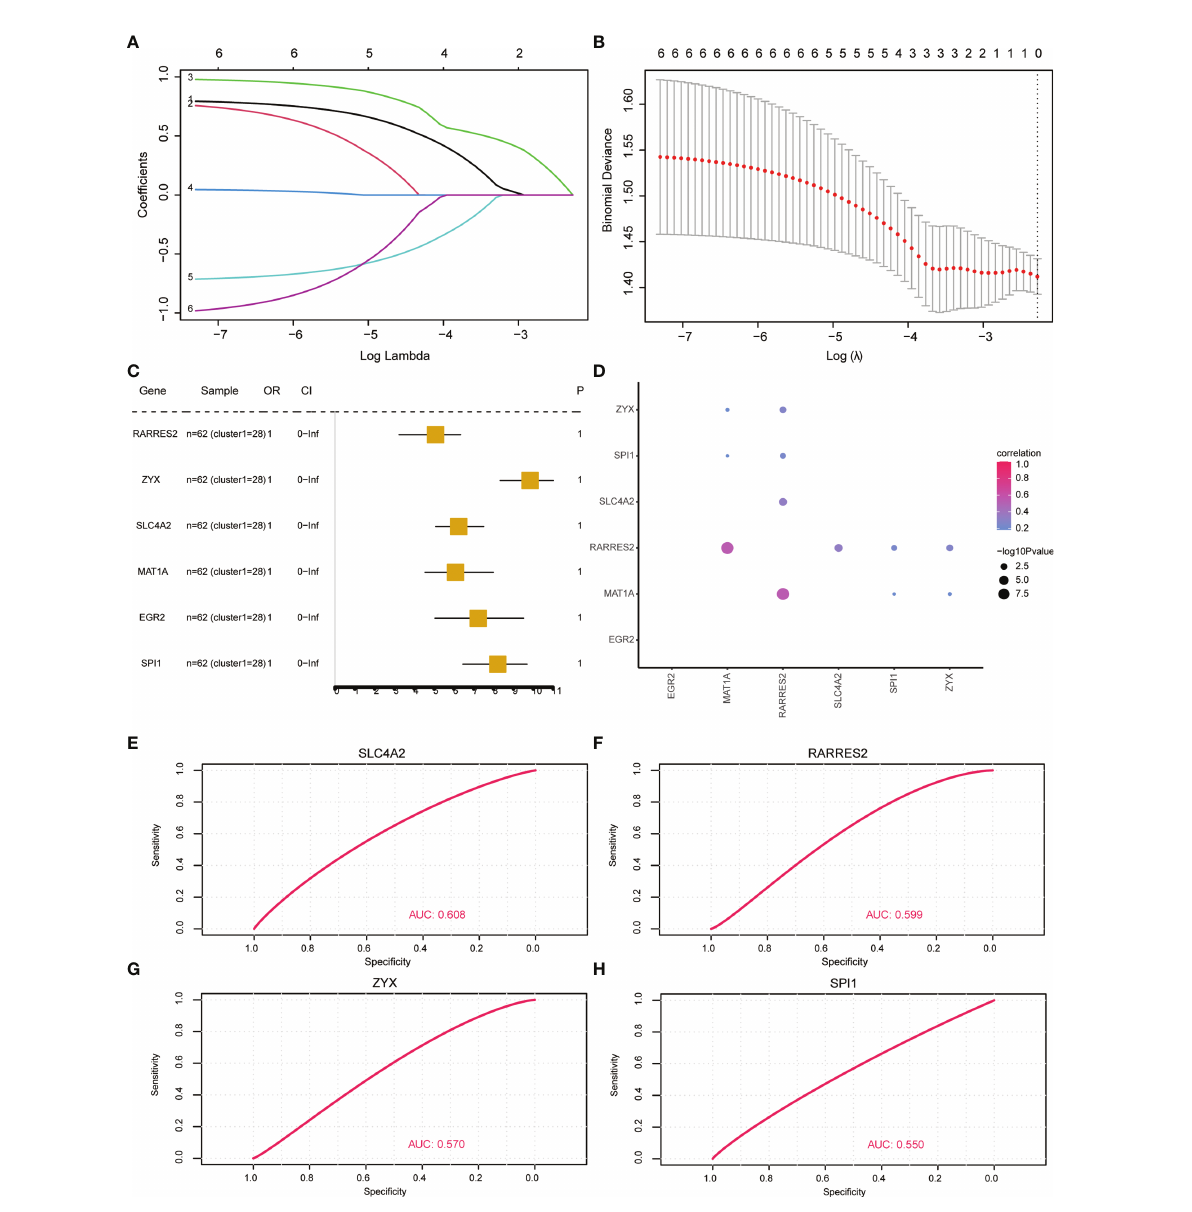
FIGURE 8 Key gene correlation analysis based on osteoporosis subtypes. (A, B) Lasso regression analysis results. (C) Univariate analysis results. (D) Similarity between key genes, the size of the point represents signi fi cance; the larger the point, the more signi fi cant the color indicates the correlation, and the redder the color, the more relevant. (E – H) : ROC curve, indicating the diagnostic performance of the